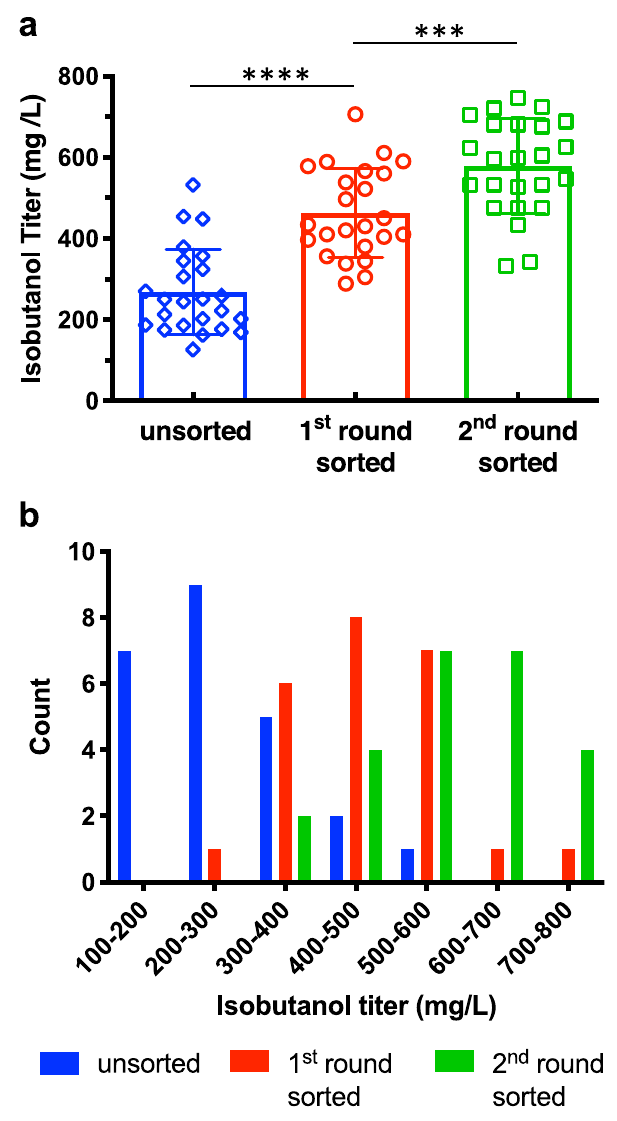
Fig. 2 Applying the biosensor in its isobutanol con fi guration for high- throughput screening of a library of strains combinatorially transformed with the mitochondrial isobutanol biosynthetic pathway. a Isobutanol titers of 24 colonies randomly selected from unsorted (blue), fi rst round sorted (red), or second round sorted (green) populations derived from a library of strains transformed with constructs overexpressing different combinations of the mitochondrial isobutanol pathway. All data are shown as mean values. Error bars represent the standard deviation of the titers of the 24 colonies analyzed. A two-sided t -test was used to determine the statistical signi fi cance of the differences in isobutanol titers of analyzed strains from each population; From left to right: P < 0.0001, P = 0.001; *** P ≤ 0.001, **** P ≤ 0.0001. b Histogram showing the number of colonies exhibiting different ranges of isobutanol production, out of the same 24 randomly selected strains from the unsorted (blue), fi rst round sorted (red), or second round sorted (green) populations shown in ( a ). Source data are provided as a Source Data fi